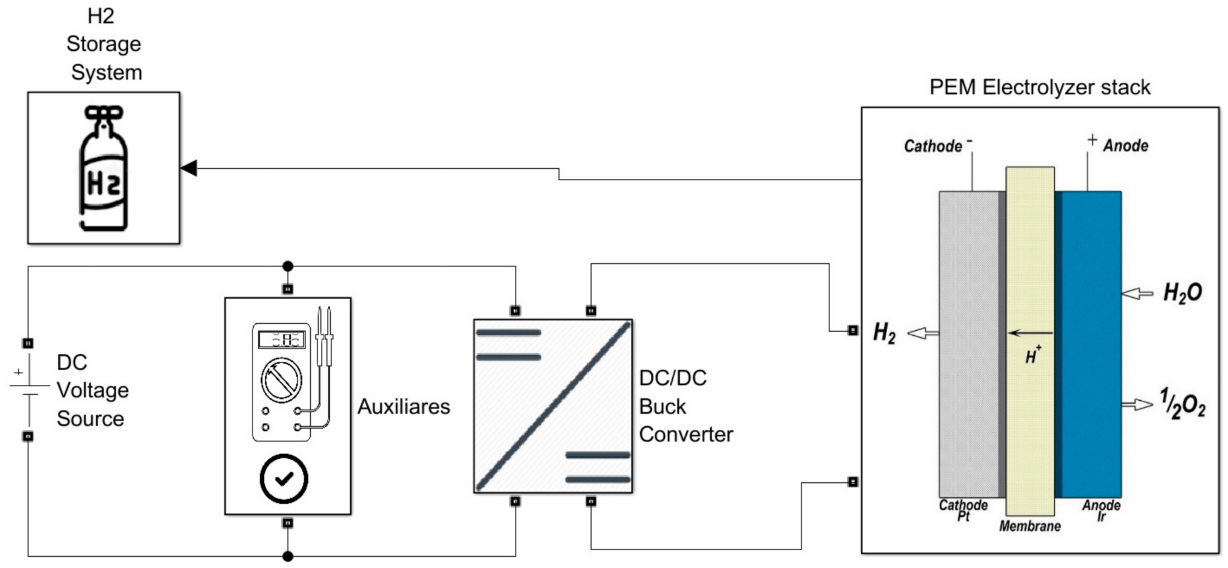
Figure 1. Layout of the PEM electrolyzer system in the Simulink ®